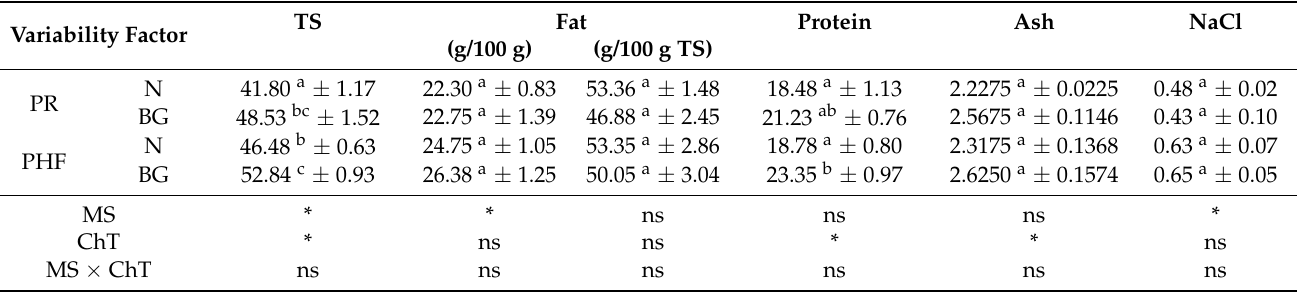
Table 2. Chemical composition of fresh cheeses (g/100 g if not stated otherwise, average ± SE, n = 4). Variability